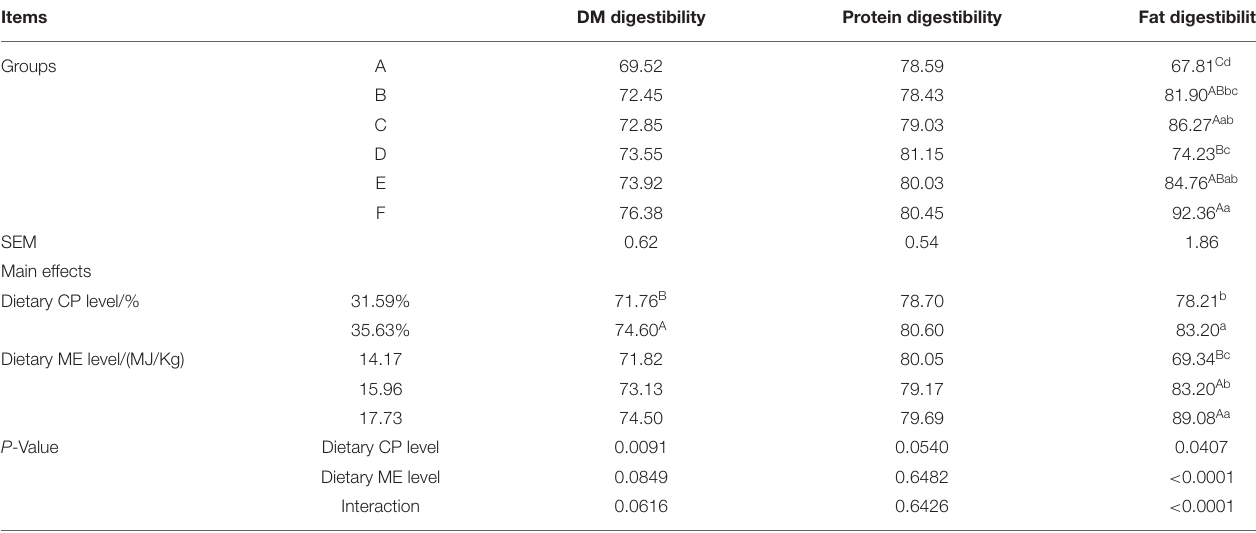
TABLE 4 | Effects of energy and protein levels on nutrient utilization of mink during growing period 1 %.